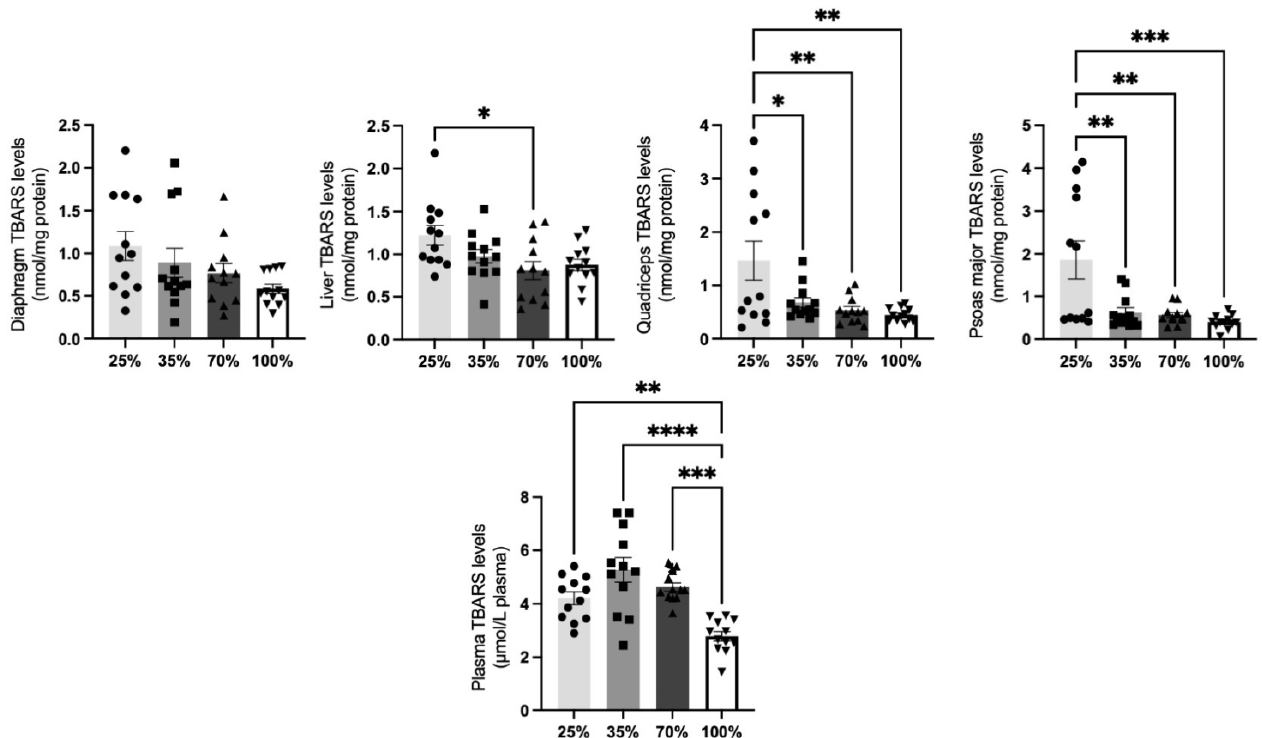
Figure 9. TBARS levels at all 4 d.s. of kids. * denotes significant difference with p < 0.05, ** denotes significant difference with p < 0.01, *** denotes significant difference with p < 0.001, **** denotes significant difference with p < 0.0001.